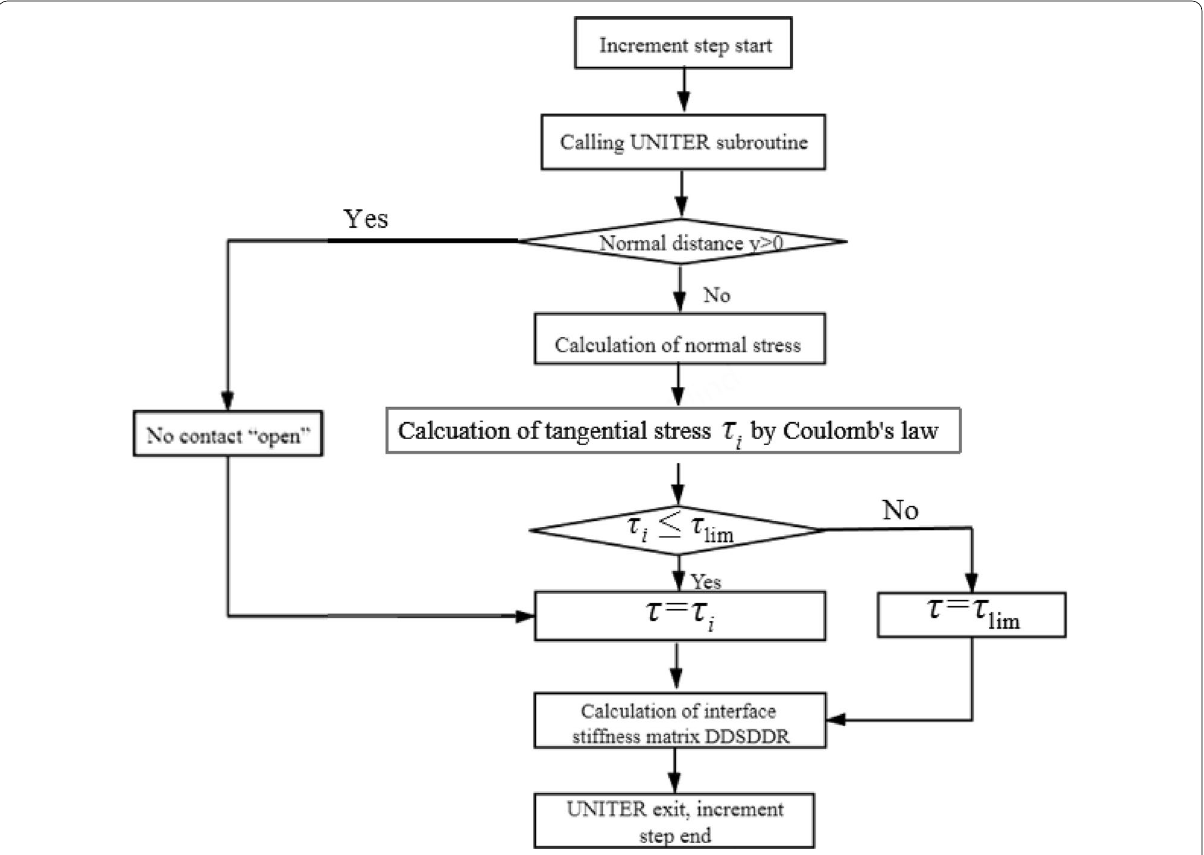
Fig. 12 Flowchart of UINTER subroutine compilation